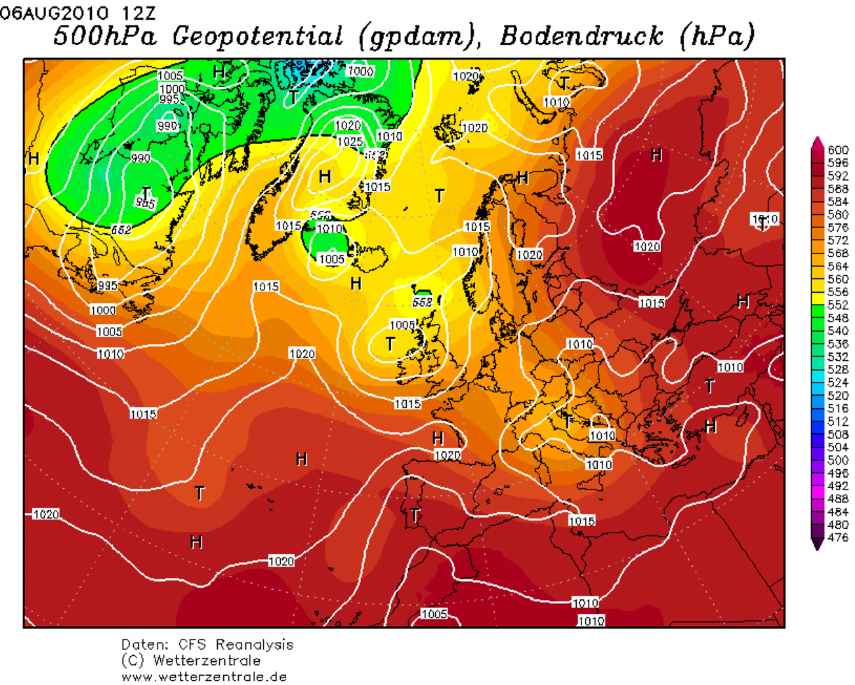
Figure A1. The 500hPa geopotential over Europe on 6 August 2010 (source: https://www.wetterzentrale.de).